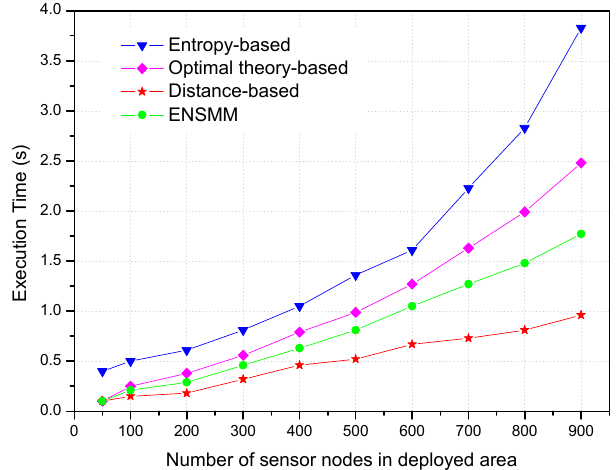
Figure 10. Comparison of execution time versus the number of nodes in deployed area.